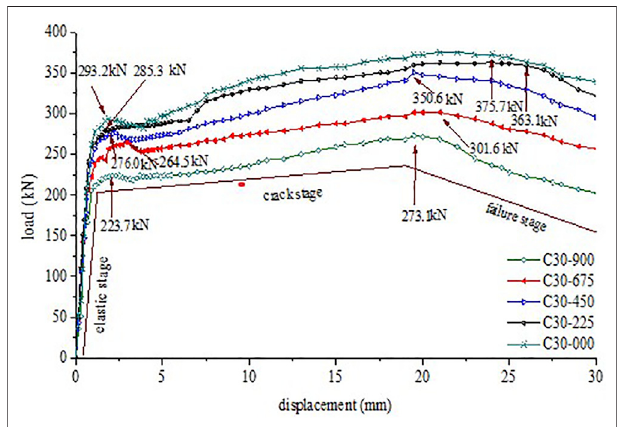
FIGURE 16 | In fl uence of tension direction grade on